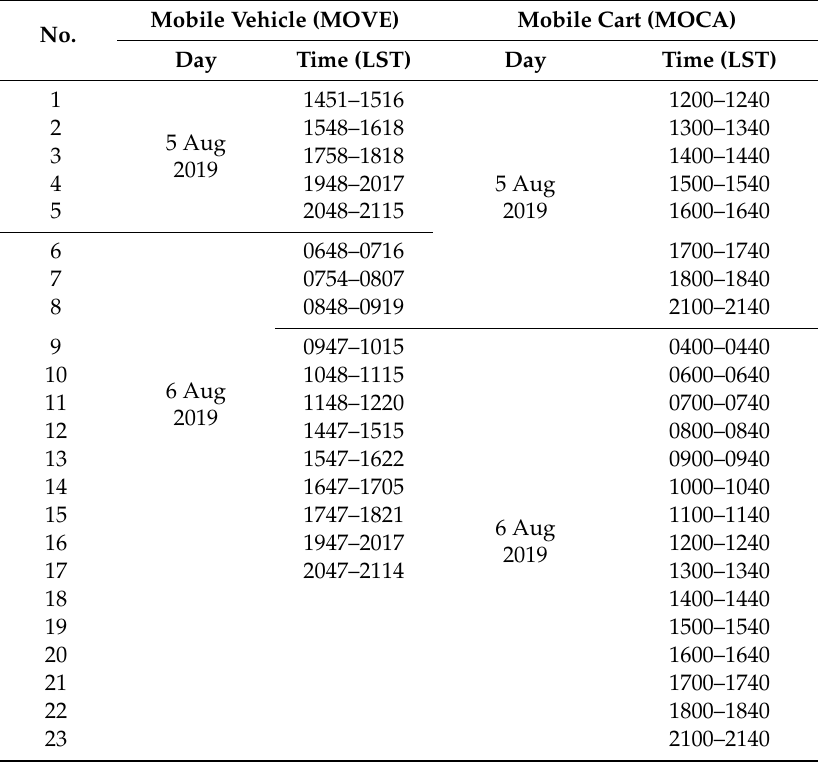
Table 3. Observation time for mobile vehicle and cart during the BBMEX